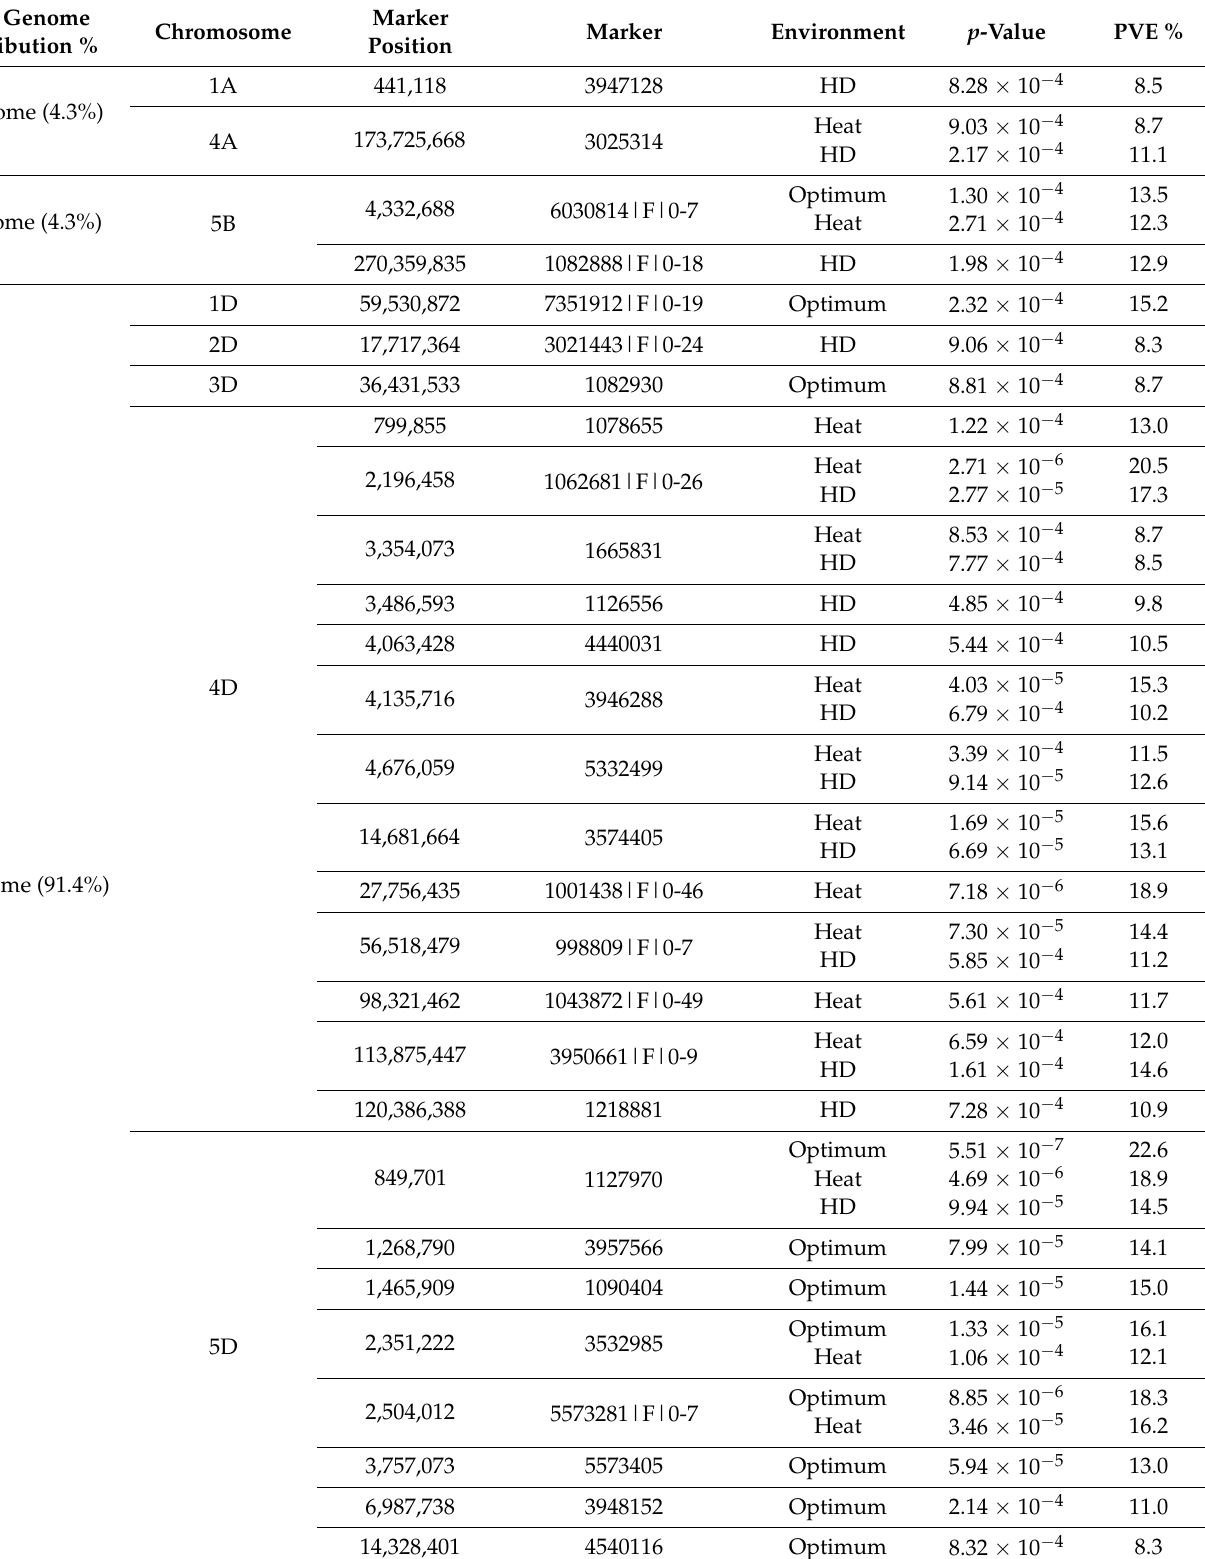
Table 2. Marker trait associations of hardness grown under optimum, heat, and HD conditions. Total